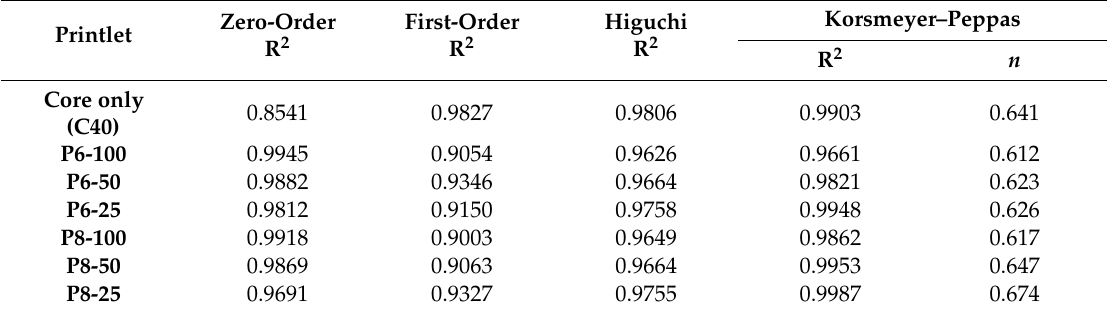
Table 4. Statistical parameters of the printlets drug release data after fitting them with di ff erent kinetic